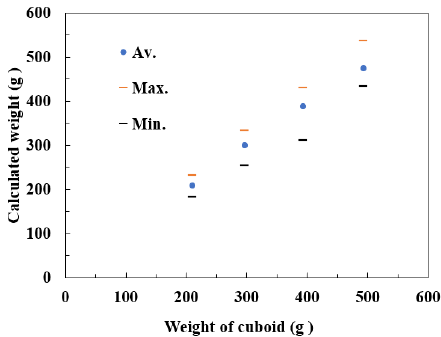
Figure 13. Relationship between the weight of the cuboid and the calculated weight, measured nine